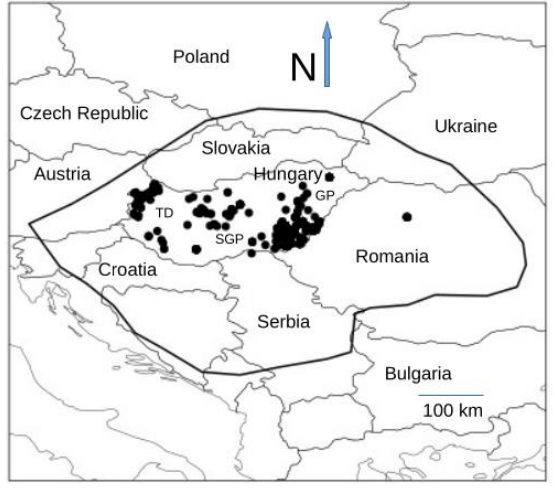
Figure 1. Map of the study region indicating country borders (thin black lines), the boundaries of the Carpathian Basin (thick black line), and the occurrence points of the Great Bustard. Abbreviations of areas within the study region: TB — Transdanubia; GP — Great Plain; SGP — Southern Great Plain.